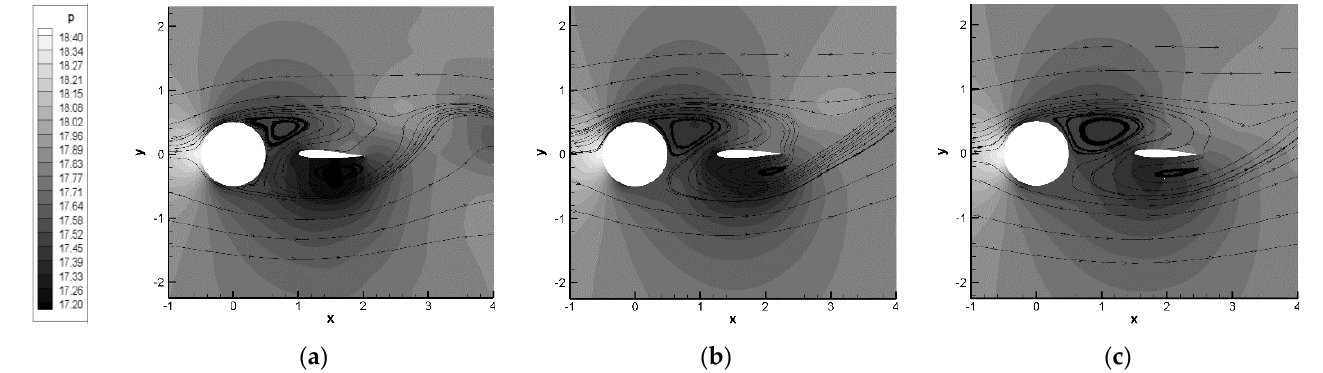
Figure 16. Interaction between vortex from upper and lower surfaces ( T / T 0 = 0.5): ( a ) x / D = 1.0; ( b ) x / D = 1.25; ( c ) x / D = 1.5.